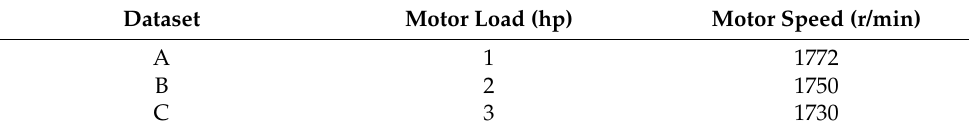
Figure 5. CWRU bearing test rig [32]. Table 3. Working conditions studied in this work.